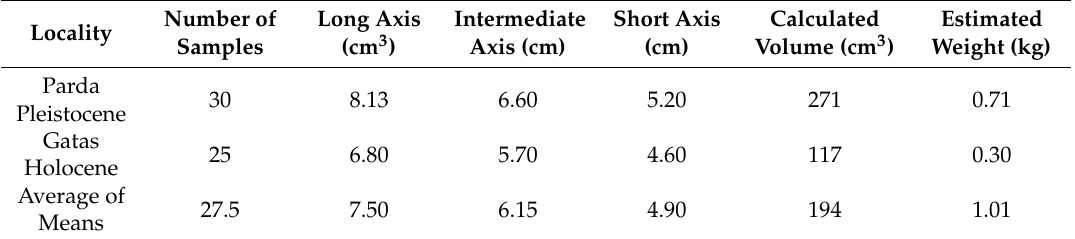
Table 1. Summary data from Appendix A (Tables A1 and A2) listing mean values for rhodoliths measured across long, intermediate, and short axes, rhodolith volume, and estimated weight. Note: the density magnesium-rich carbonate at 2.6 gm / cm 3 applies uniformly to calculations for weight estimates.